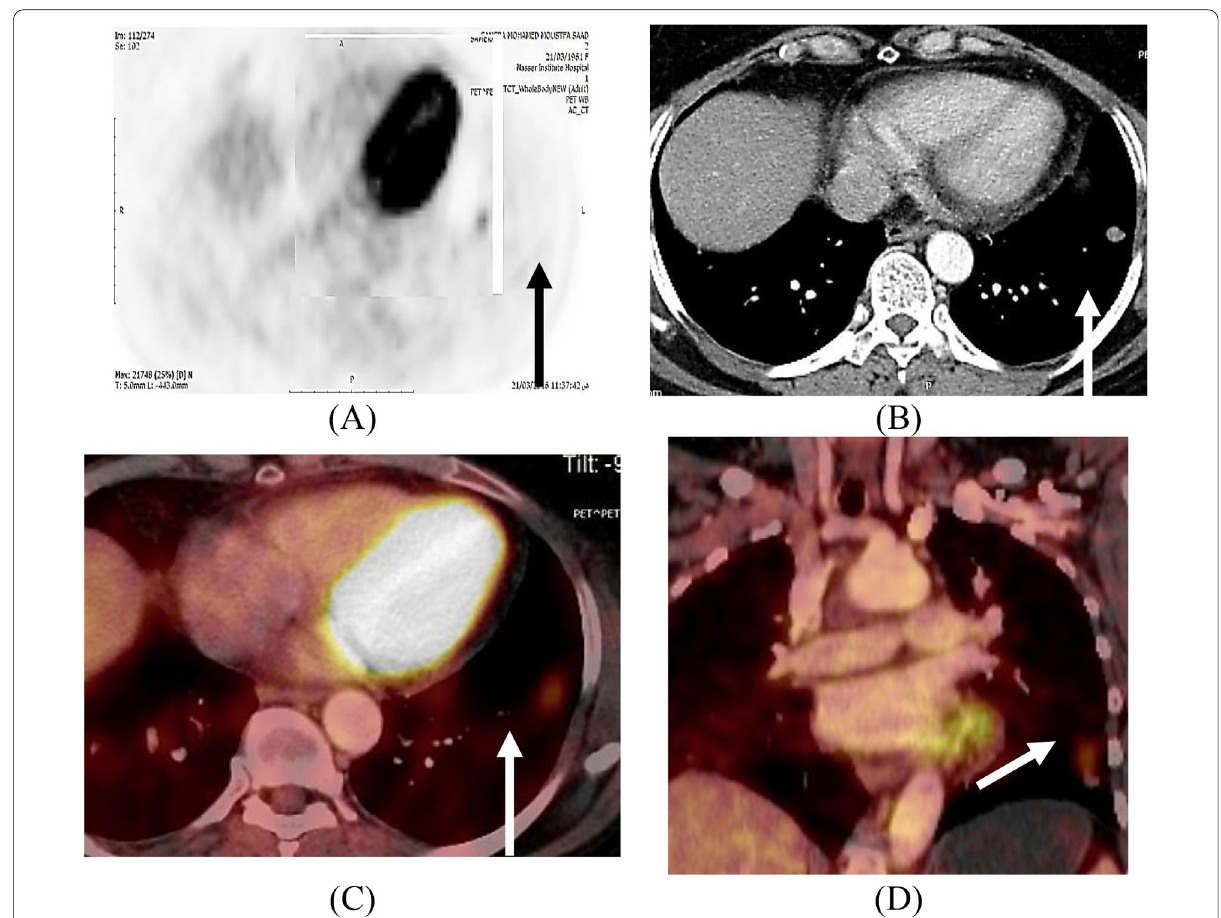
Fig. 1 A fifty years old female patient, diagnosed with multi-centric papillary differentiated cancer thyroid,underwent total thyroidectomy, followed by 120 mCi RAI-131 ablation for. At follow up thyroglobulin level elevation 15 mg/dl detected, Iodine whole body diagnostic scan and ultrasound of the neck were negative, PET/CT was done and showed solitary small sized left lower lung lobe pulmonary nodule SUVmax ~ 11.8. Which ensure the metastatic nature of this lesion. Axial PET only ( a ), CT ( b ) Axial & Coronal fused PETCT images ( c , d ) showed pulmonary nodule